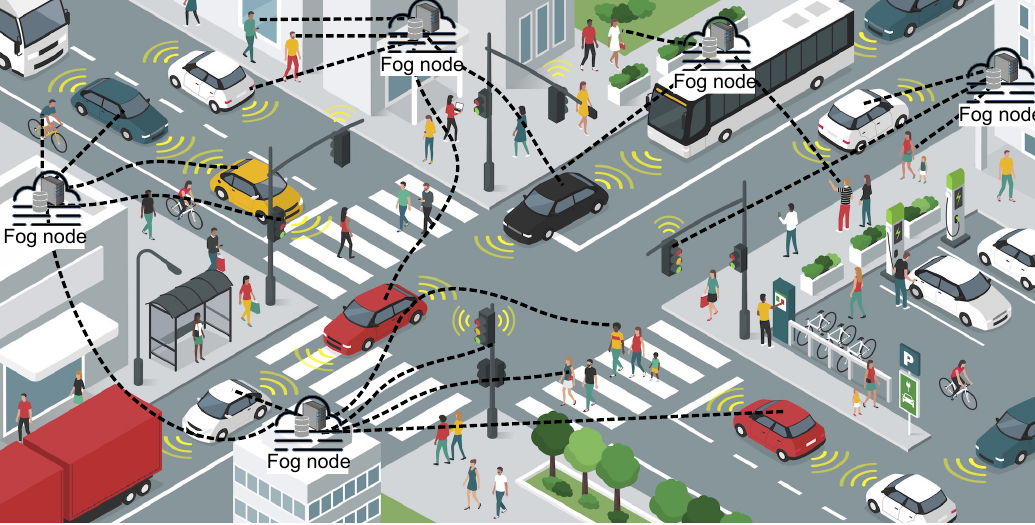
Figure 4. Fog computing in Intelligent Transportation